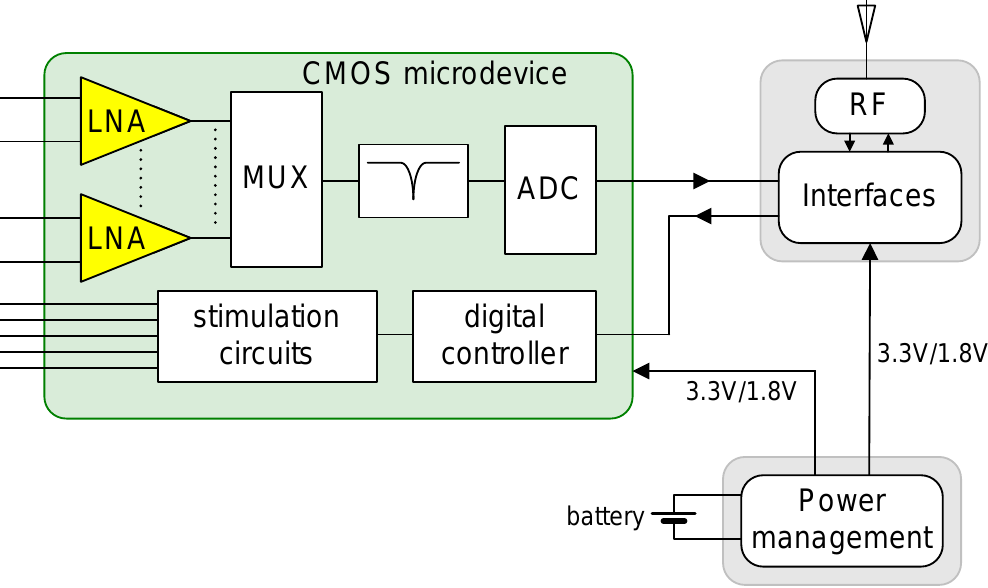
Figure 2. A block diagram of a CMOS microdevice containing the acquisition, neurostimulator and control modules for DBS. The LNA module presented in this paper is filled with the yellow color.